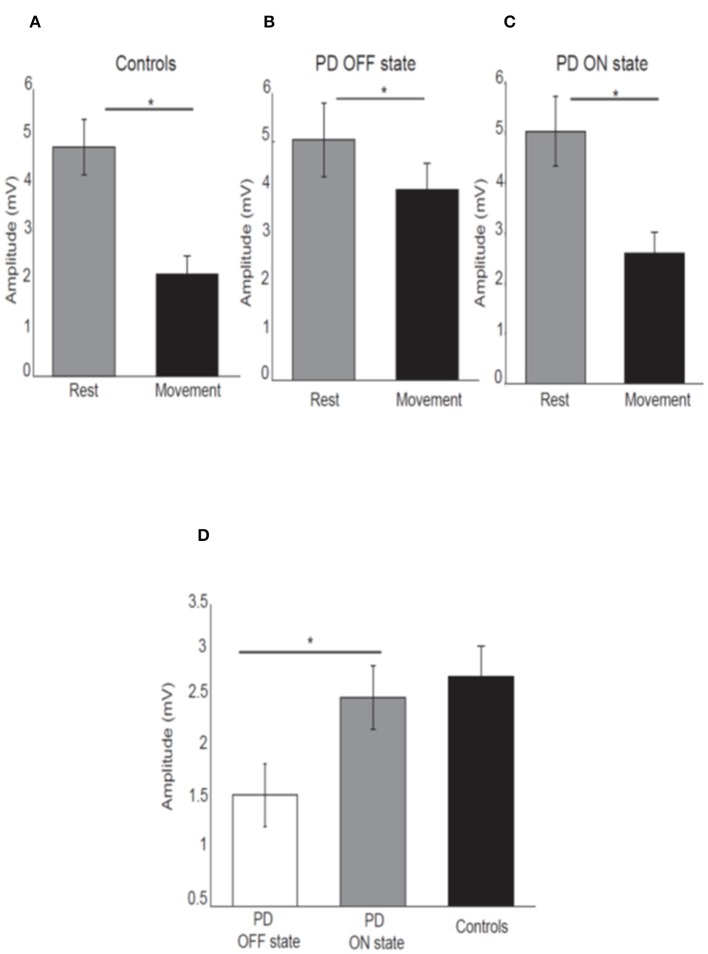
Mean amplitude of the N20-P25 component for each condition for control subjects (A), PD patients OFF medication (B), ON medication (C). Error bars show standard error of the means. Mean difference of the N20-P25 amplitude between rest condition and movement condition in PD patients OFF medication, ON medication and controls (D). *p < 0.05.